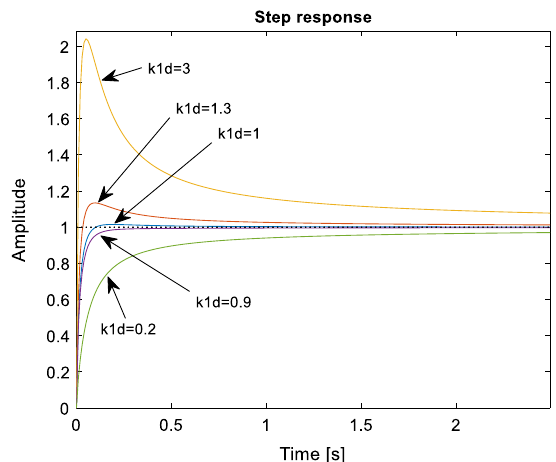
Fig. 37 Step response of the RSC control circuit using FFOADRC (for k 2d 1, α 0.7, ω c 10, and different k 1d ) = = =